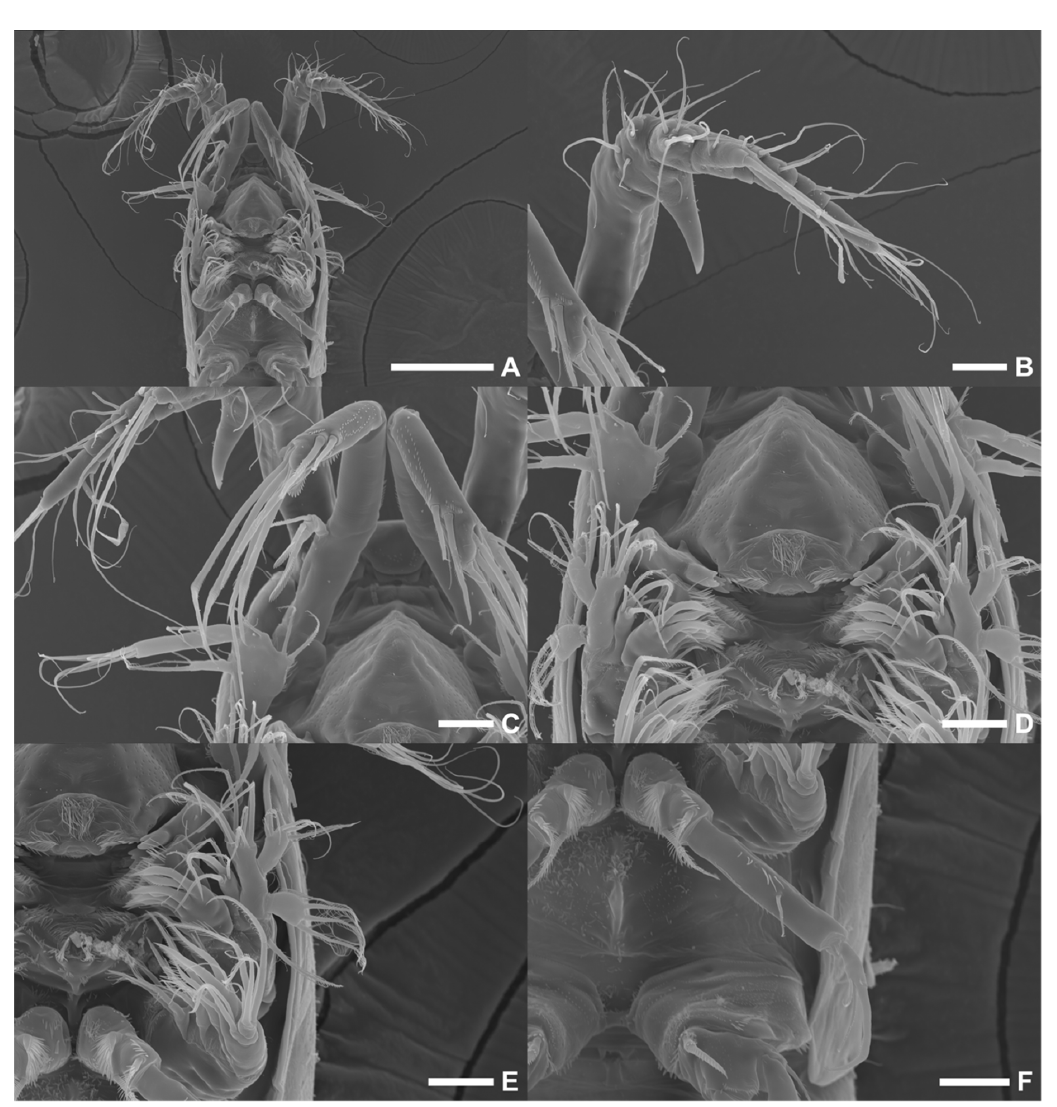
Figure 6. Scanning electron microscopy images of Phyllopodopsyllus saywakimi sp. nov. female (paratype 4) in ventral view: ( A ) cephalothorax; ( B ) antennule; ( C ) antenna and mandible (excluding coxa); ( D ) mouth parts around oral opening; ( E ) maxillule and maxilla; ( F ) maxilliped. Scale bars: ( A ) 100 µm; ( B – F ) 20 µm.